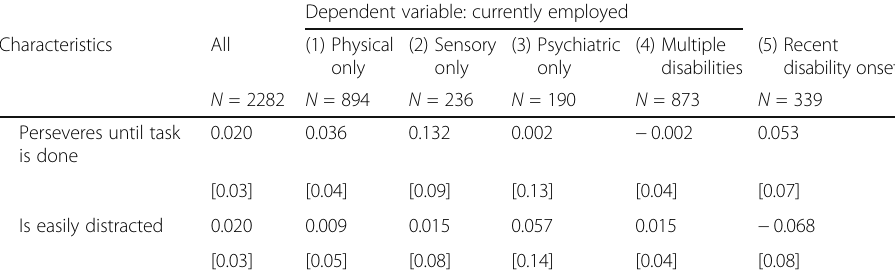
Table 4 Regression results of employment on workplace accommodations, overall, and by disability subgroup (Continued) Dependent variable: currently employed Characteristics